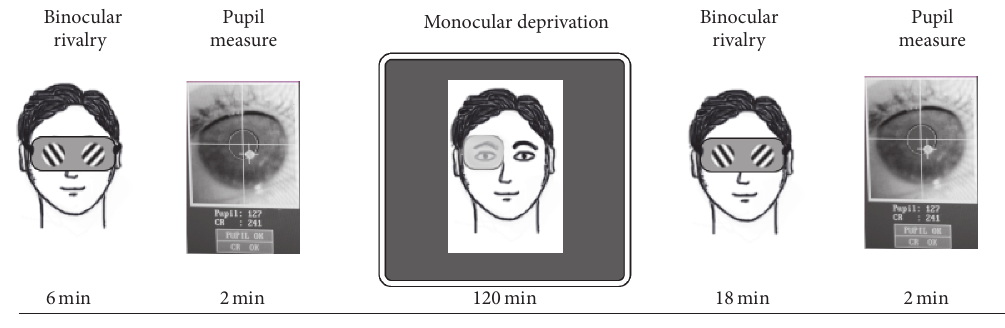
Figure 1: Diagram of the experimental procedure. Baseline binocular rivalry dynamics and pupillary measurements were obtained before deprivation (2 × 180sec binocular rivalry blocks, 2 minutes of pupil measurement in total darkness). Short-term monocular deprivation was achieved by having observers wear a translucent eye-patch over the dominant eye for 2 hours. Immediately after eye-patch removal, 4 × 180 sec binocular rivalry blocks were acquired within a temporal interval of 18 minutes. Binocular rivalry tests were followed by 2 minutes of pupillary measurement in the